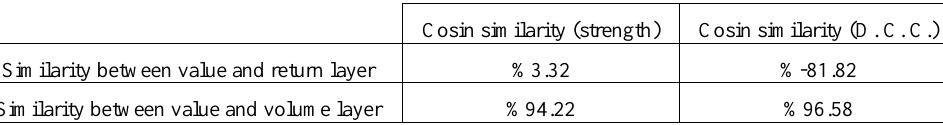
Table 2. Similarity of different layers to the value layer